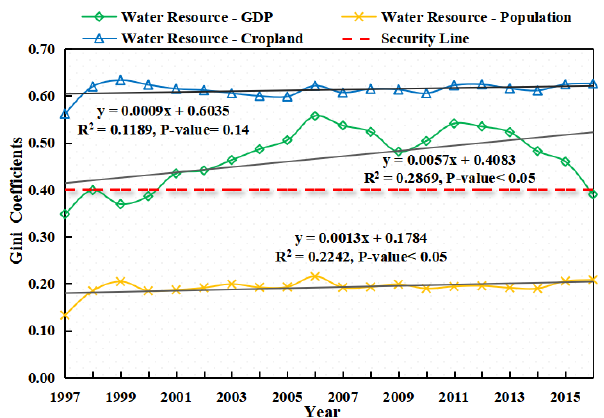
Figure 4. Variations in the Gini coefficient between water resources and socio-economic elements in Central Asia from 1997 to